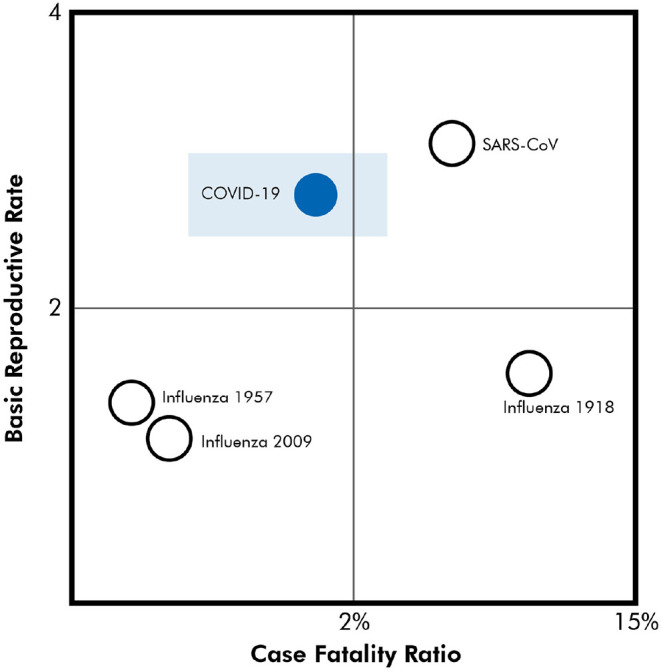
Reproduction rate and case-fatality rates for major respiratory virus pandemics (4, 5). Rectangle donates case fatality range from multiple publications.